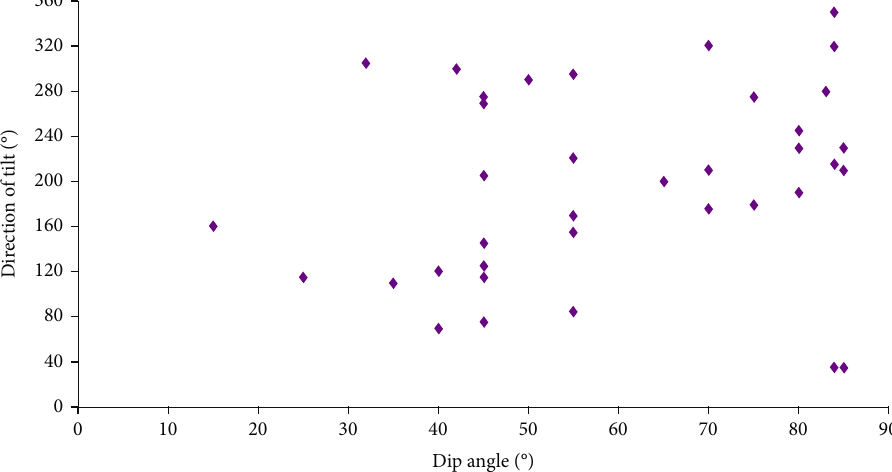
Figure 5: Distribution of discontinuity